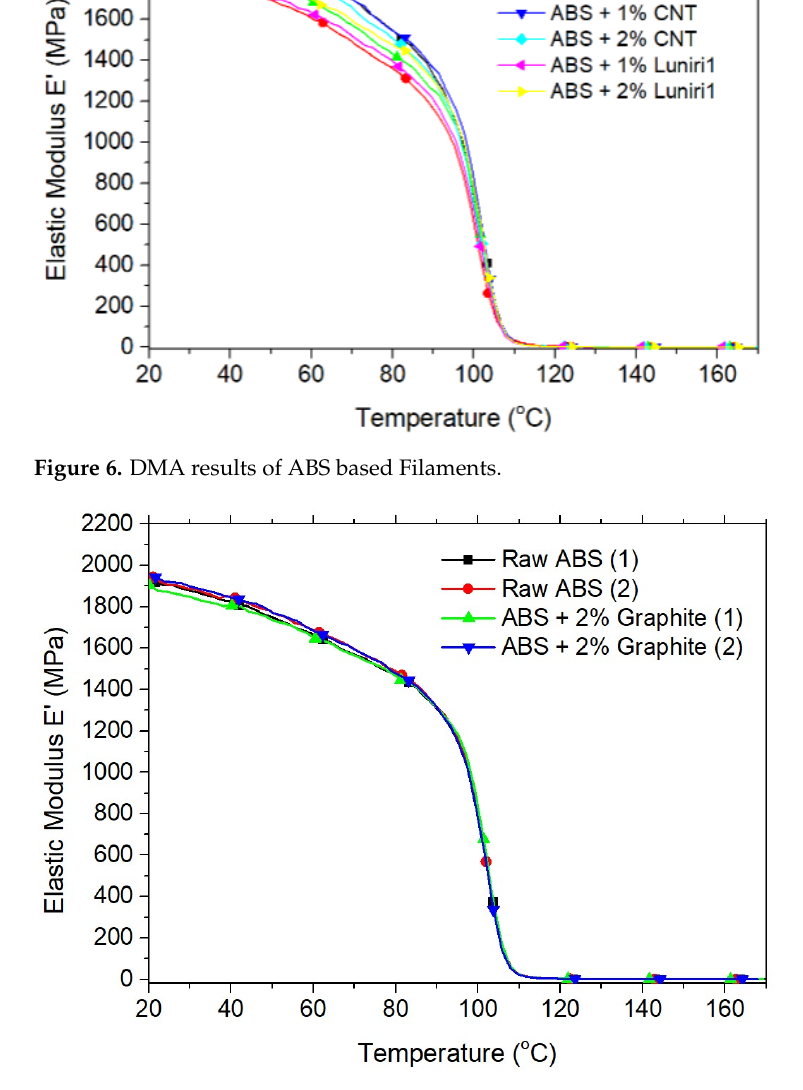
Figure 7. DMA results of ABS and ABS 2% graphite filaments.